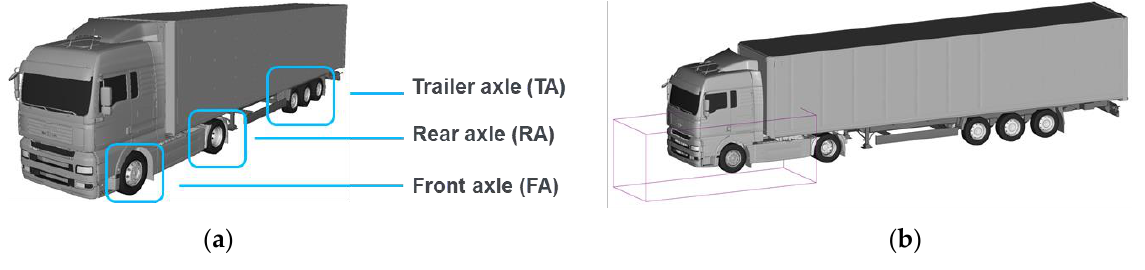
Figure 10. ( a ) Vehicle geometry used for the investigations; ( b ) Local simulation region.